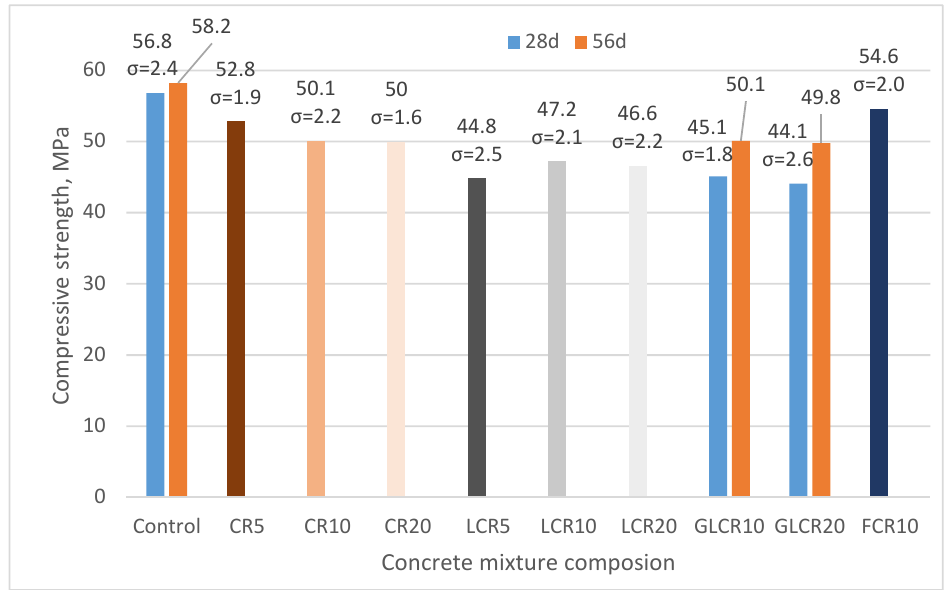
Figure 2. The change in compressive strength of concrete.